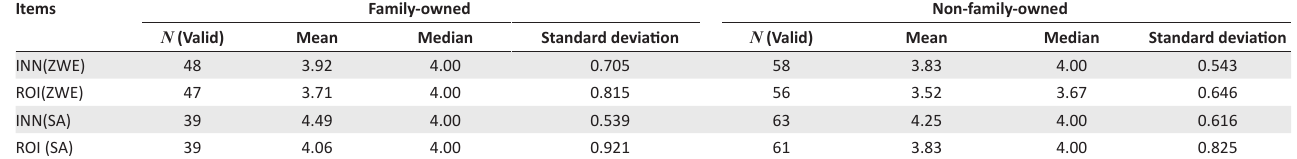
TABLE 2: Innovation and return on investment in Zimbabwean and South African small and medium-sized enterprises Items Family-owned